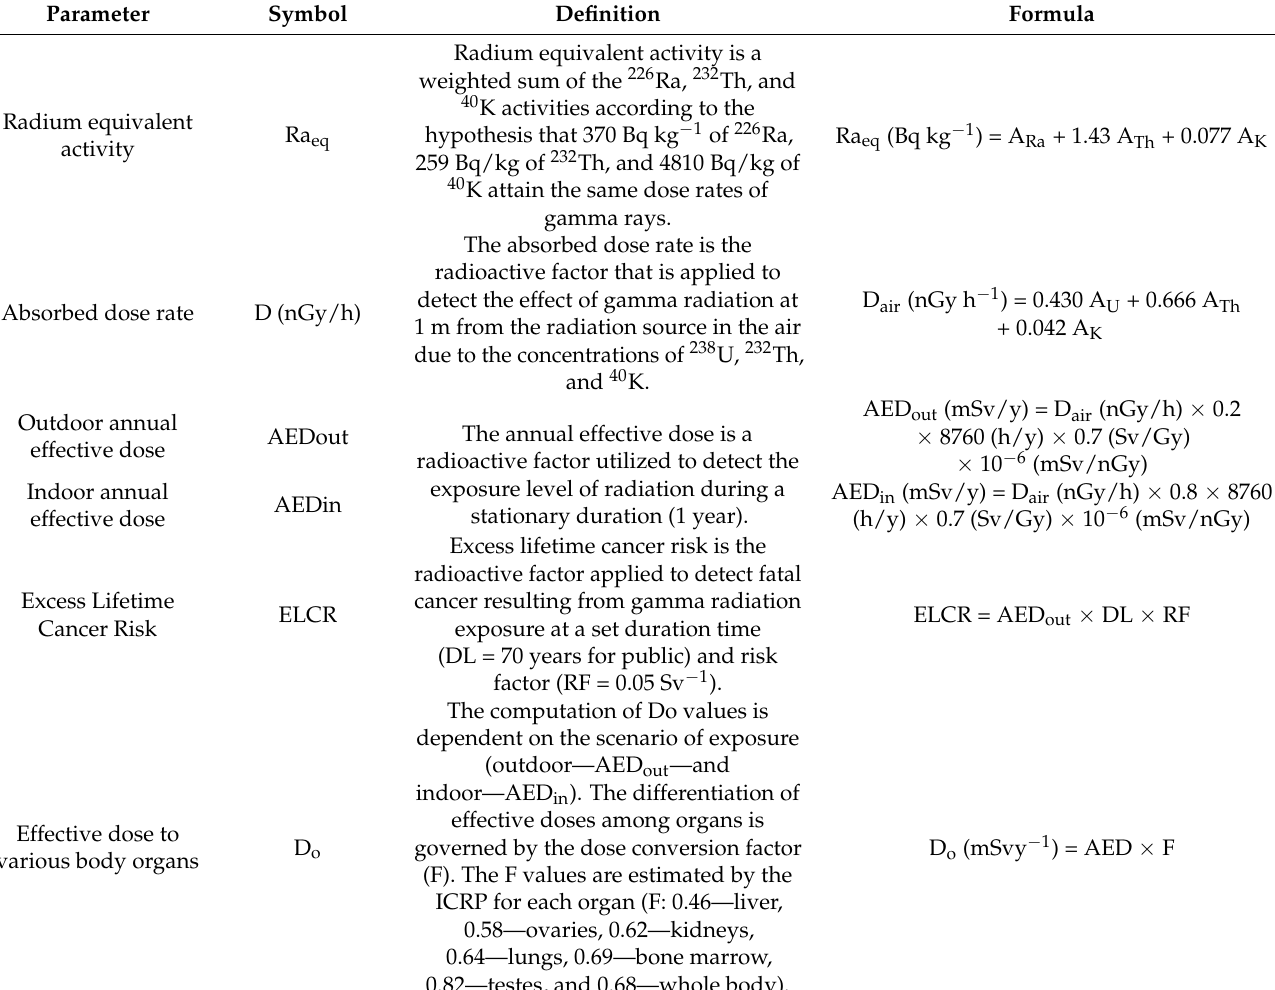
Table 1. Important radiological parameters and